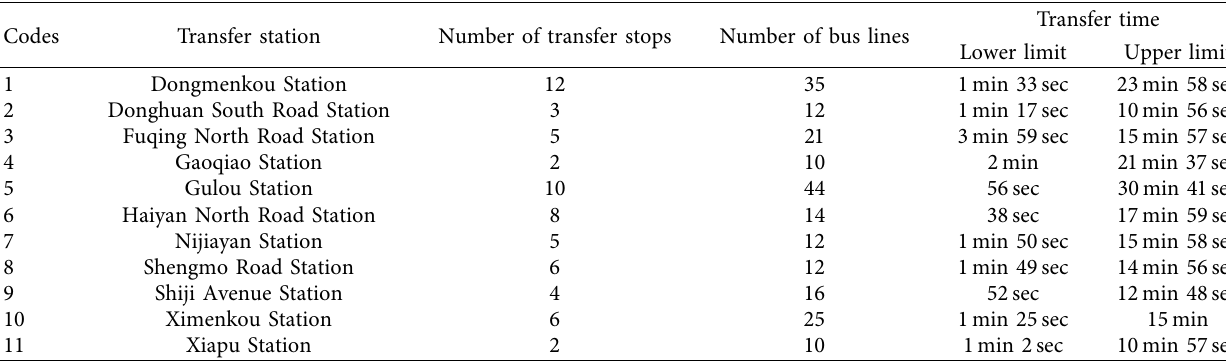
Figure 4: Locations of 11 selected transfer stations (codes listed beside the stations). Table 2: Data description.